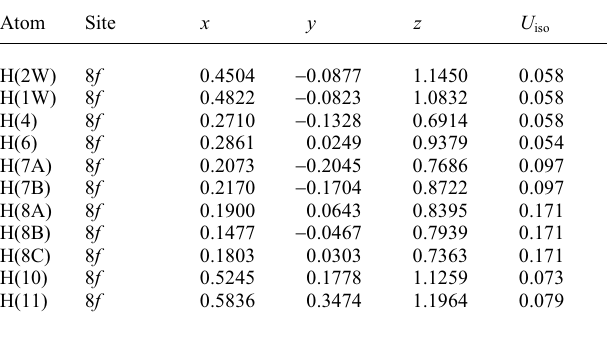
Table 2. Atomic coordinates and displacement parameters (in Å 2 )